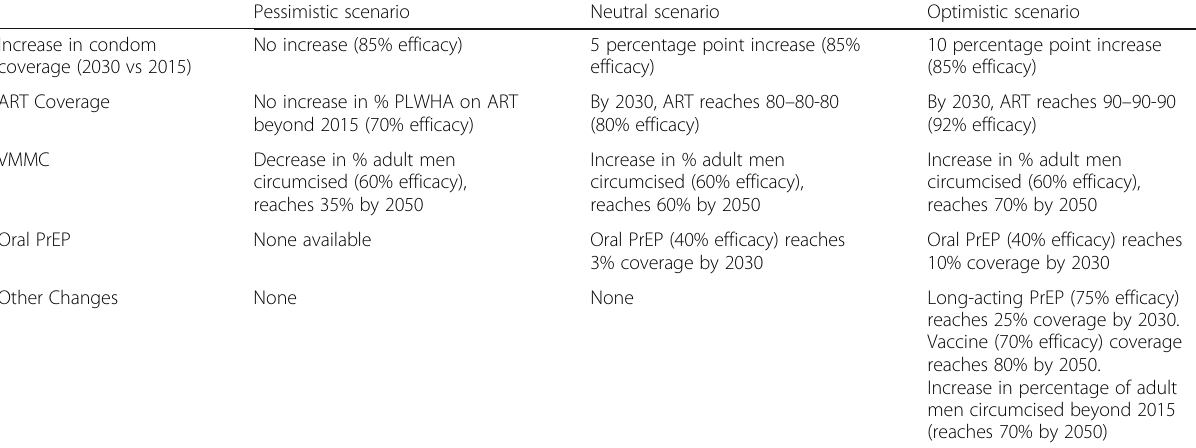
Table 1 Future HIV epidemic scenarios Pessimistic scenario Neutral scenario Optimistic scenario